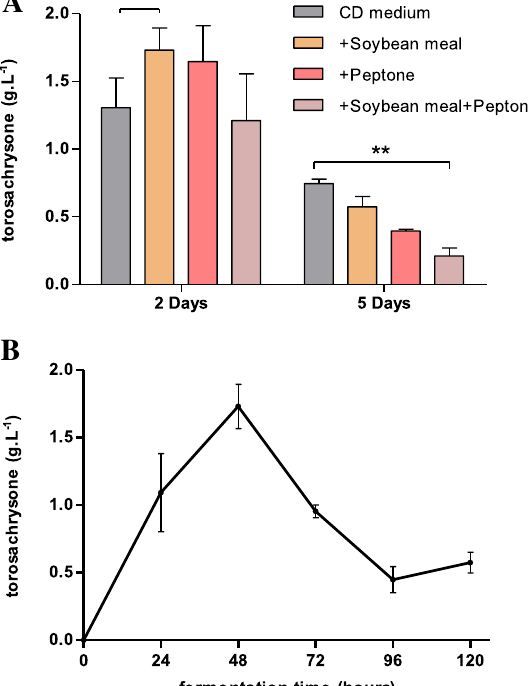
Fig. 4 Optimizing the fermentation conditions of the engineered torosachrysone ( 4 )‑producing strain Ao toaA/toaB–toaC . A Effects of different nitrogen sources in fermentation CD medium on compound 4 production. *